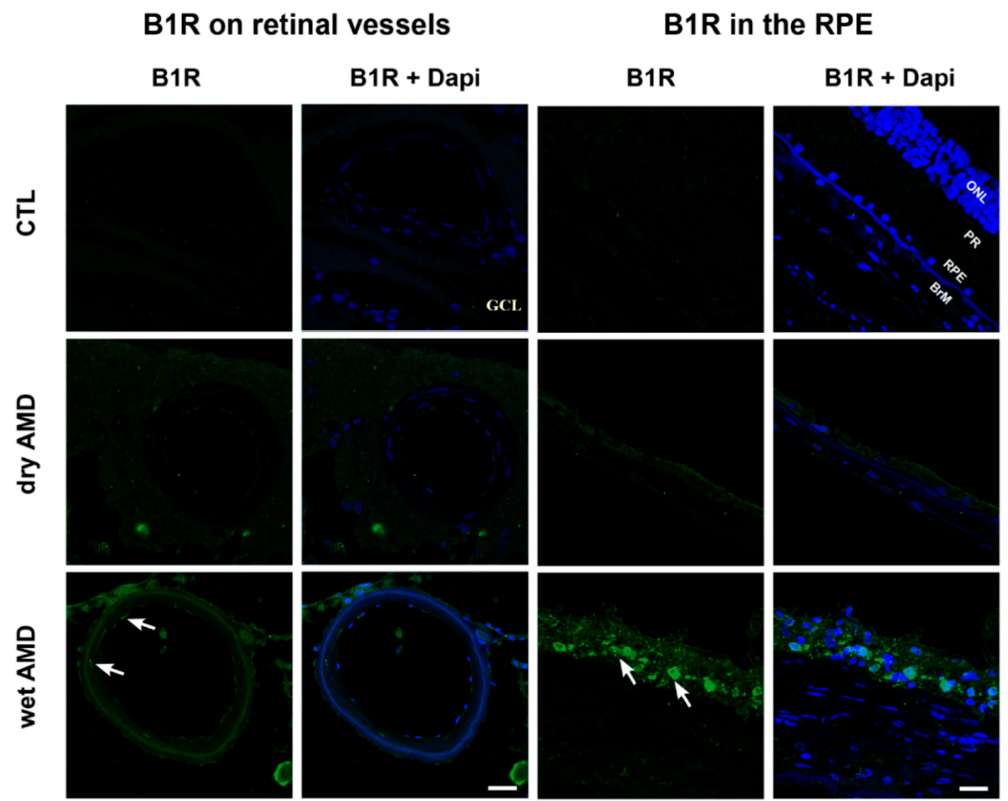
Figure 3. Microphotographs of immunolocalization of B1R in smooth muscle and endothelial cells of blood vessels (arrows) and in the retinal pigment epithelium (RPE) (arrows) of human AMD retina, compared to the control (CTL). Sections are counterstained for 4 ′ ,6-diamidino-2-phenylindole (DAPI; blue), which labels cell nuclei. Images were obtained at 60×. Scale bar: 40 μ m. BrM: Bruch’s membrane, GCL: ganglion cell layer, ONL: outer nuclear layer, PR: photoreceptor layer, RPE: retinal pigment epithelium.